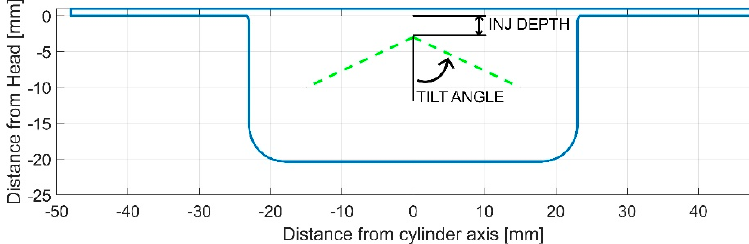
Figure 4. Injector depth and tilt . Table 6. Details of the analyzed combustion systems .